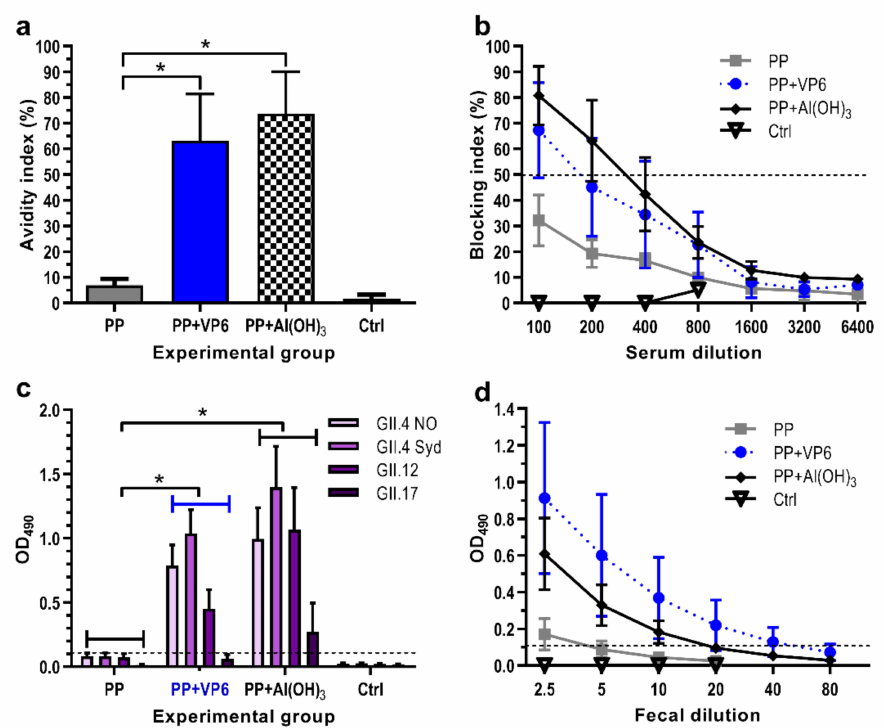
Figure 3. Functionality of antibodies following immunization with norovirus (NoV) P particles (PP) alone or formulated with VP6 or Al(OH) 3 . Control group (Ctrl) received no immunogen. ( a ) Avidity of serum IgG antibodies against NoV GII.4 VLPs. Mean avidity indices (%) with standard errors of the means of the groups are shown. ( b ) Homologous blockage of GII.4 VLP binding to HBGA by serum antibodies. Shown are the mean blocking indices (%) with standard errors of the means of the experimental groups. The horizontal dashed line represents the blocking titer 50% (BT 50 ). ( c ) Cross-reactive serum IgG responses against heterologous NoV VLPs. Group mean OD 490 values with standard errors of the means of 1:200 diluted sera are shown. Horizontal dashed line indicates the cut-o ff level (OD 490 ≥ 0.1). ( d ) Endpoint titrations of fecal IgG antibodies against NoV GII.4 VLPs. Shown are mean titration curves with standard errors of the means of the experimental groups. Horizontal dashed line indicates the cut-o ff level (OD 490 ≥ 0.1). * indicates statistically significant ( p > 0.05) di ff erences between the